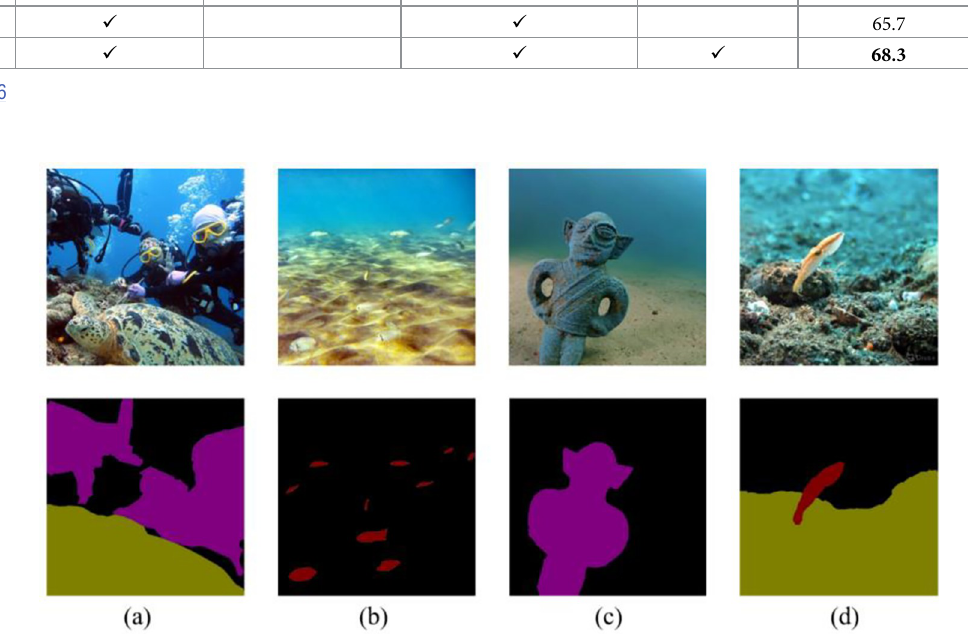
Fig 12. Failure examples of the proposed